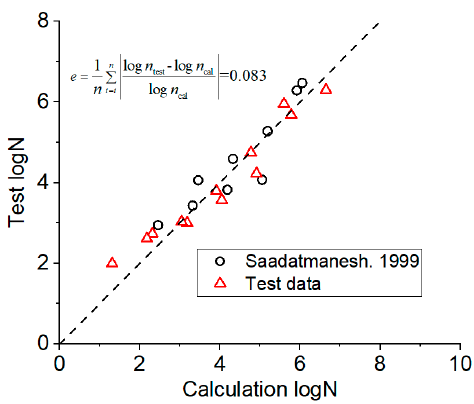
Figure 10. Between calculation results of simplified Equation (4) and test results.